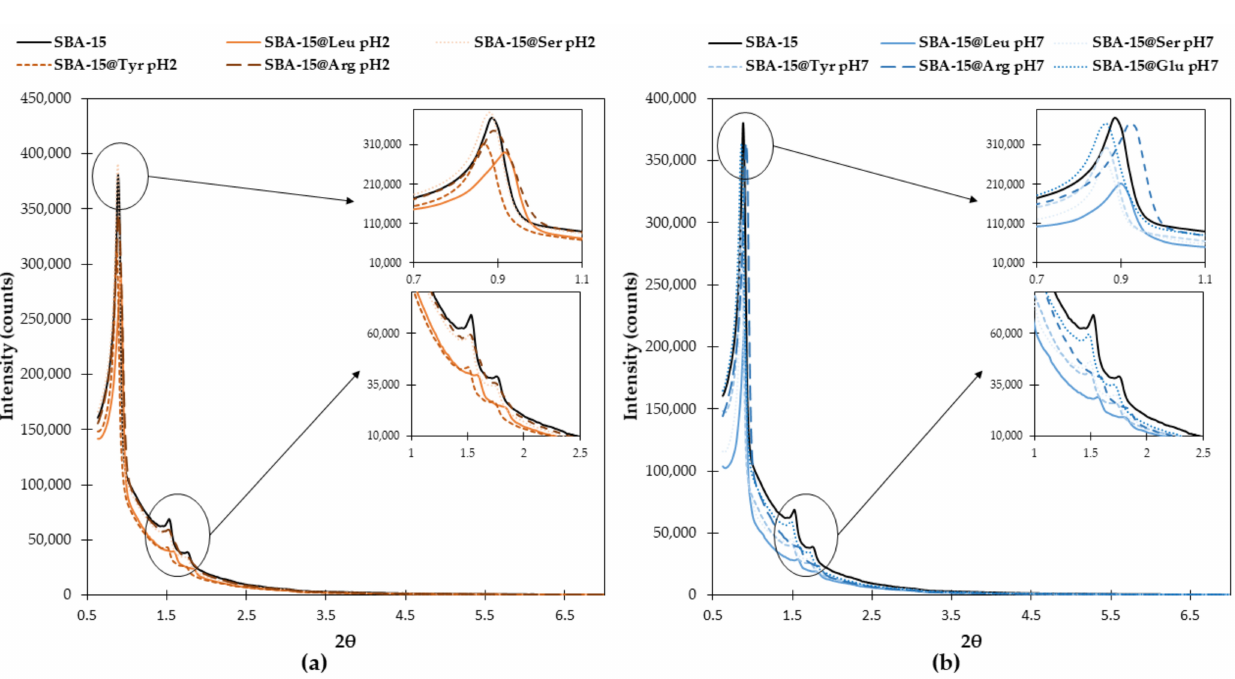
Figure 8. X-ray diffraction patterns of SBA-15 and functionalized SBA-15@AA obtained by acid catalysis ( a ) or nucleophilic catalysis at pH 7 ( b